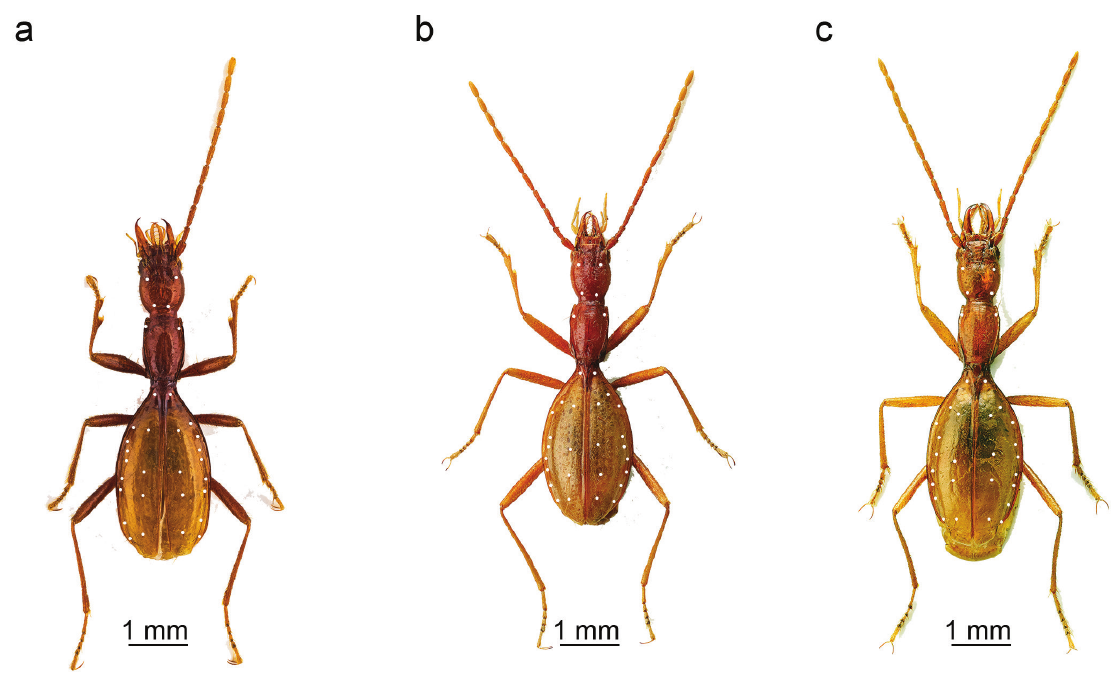
Figure 7. Habitus of morphologically similar Adriaphaenops species. Adriaphaenops petrimaris sp. n. (a) , Adriaphaenops rumi- jaensis (b) and Adriaphenops kevser (c) . Chetotaxy is presented as white points (photo courtesy of Dušan